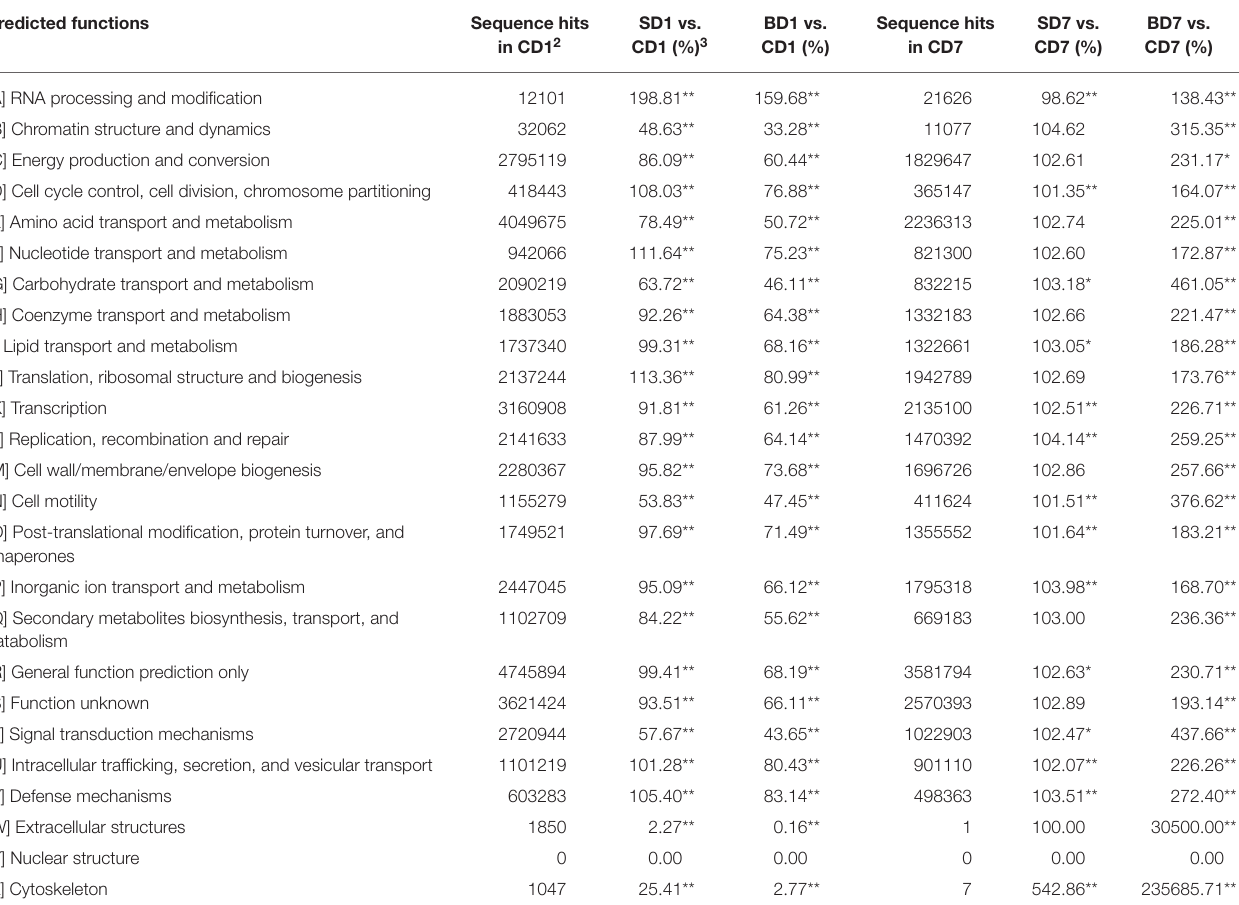
TABLE 10 | Predicated functions of PL microbiota and their relative percentages (strength) in CD, SD and BD groups on the basis of COG analysis in the PICRUSt 1 . Predicted